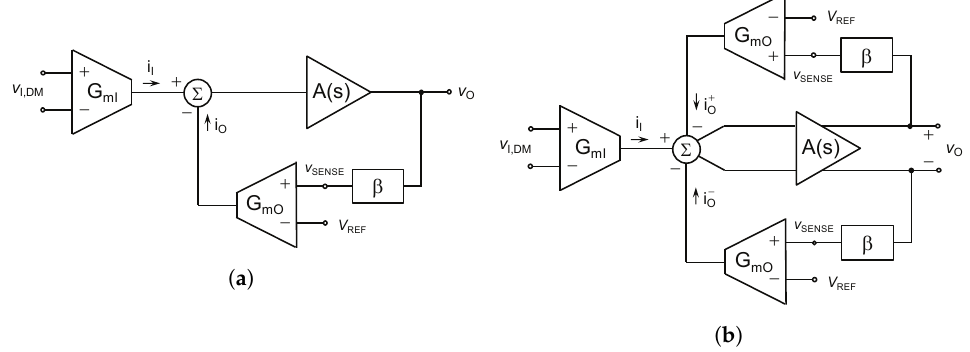
Figure 2. Block diagram of ( a ) a single-ended and ( b ) a differential ICF